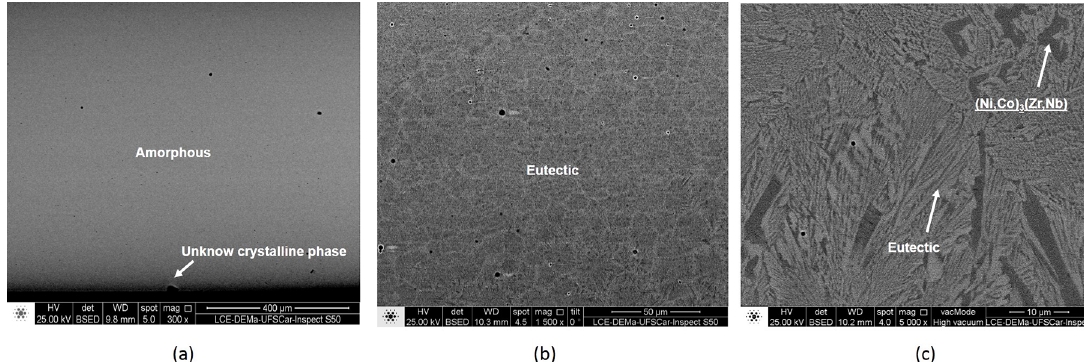
Figure 3. SEM images of: (a) 1 mm diameter rod (top) sample and (b) 2 mm diameter rod (bottom). It suggests the presence of a very fine eutectic formed by (Ni,Co)(Nb,Zr) and (Ni,Co) in a eutectic (Ni,Co)(Nb,Zr)/(Ni,Co)